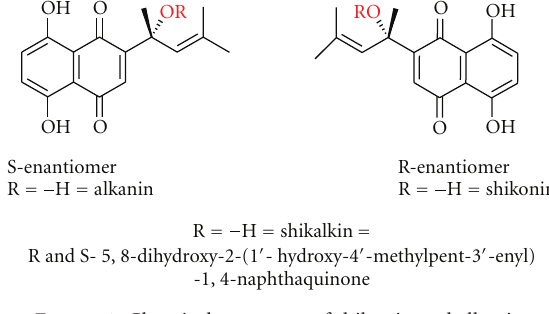
Figure 1: Chemical structures of shikonin and alkanin.